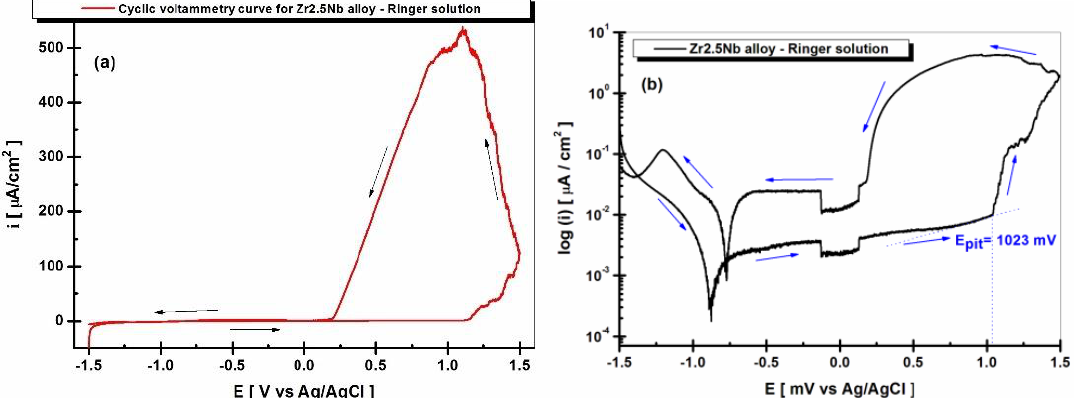
Figure 7. Cyclic voltammetry diagram (CV) for Zr2.5Nb alloy immersed in Ringer’s solution plotted with the potential scanning rate of 3 mV/s; ( a ) the current density versus potential and ( b ) log i vs. potential.